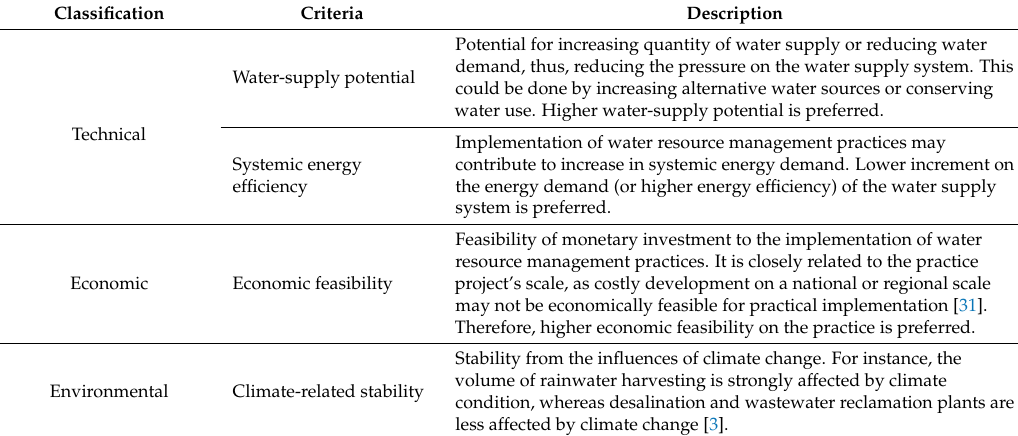
Table 2. Summary of selected performance criteria for water resource management